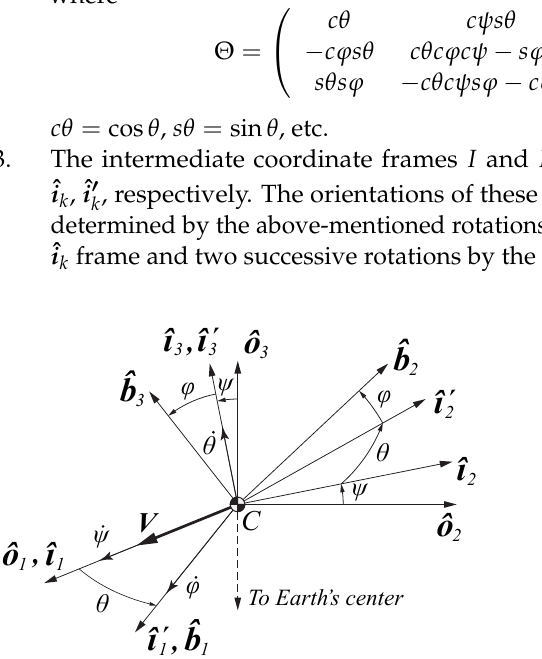
Figure 1. Coordinate frames and Euler